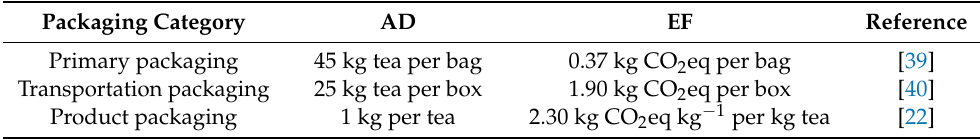
Table 4. Packaging phase data sheet.